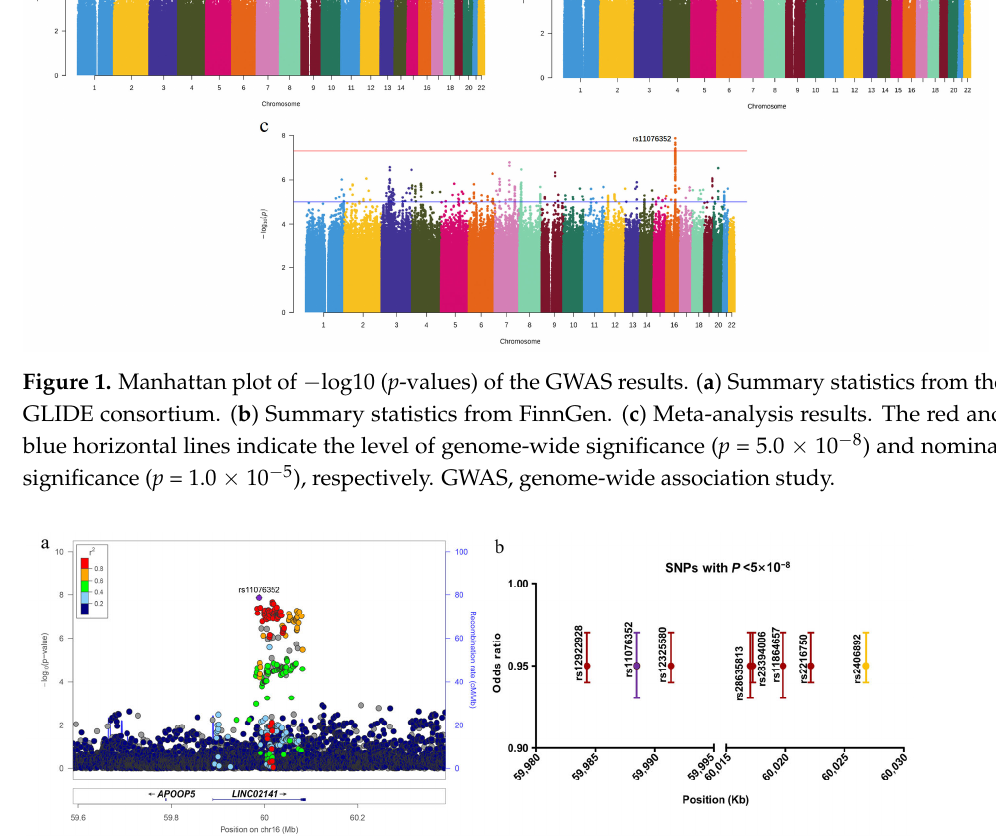
Figure 2. Regional plots and effective size of significant SNPs. ( a ) Regional plots of association results and recombination rates for the genome-wide significant SNP rs11076352. ( b ) OR and 95% CI under an additive model for SNPs with p < 5 × 10 − 8 . SNPs, single nucleotide polymorphisms; OR, odds ratio; 95% CI, 95% confidence interval.